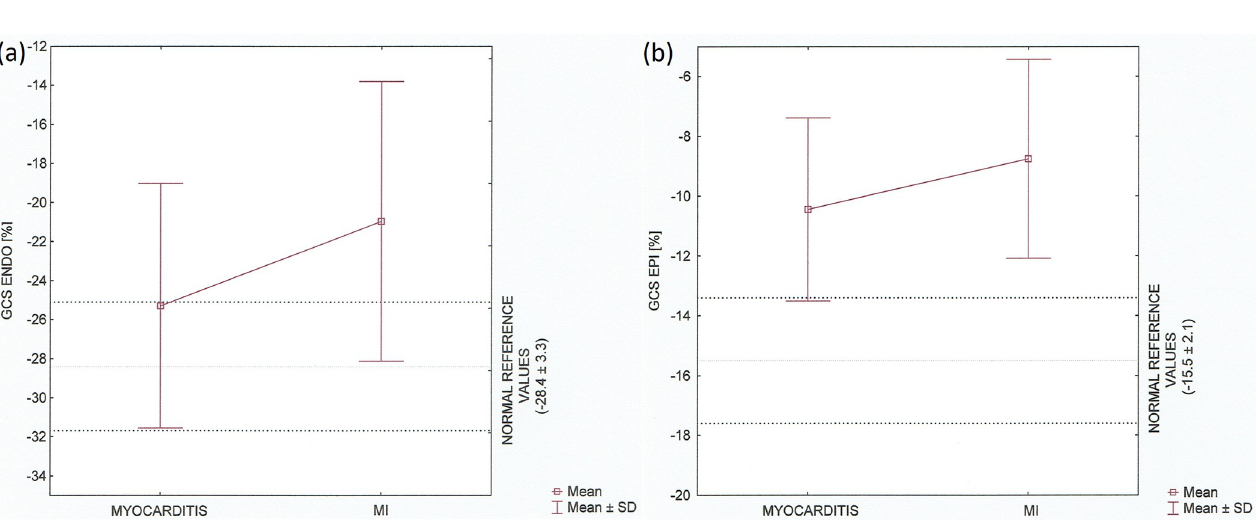
Fig 6. Global circumferential endocardial and epicardial strain in the myocarditis and MI groups. Data are shown as Tukey boxplots, taking into account normal reference values for age, p < 0.05 (a) Endocardial GCS [%]. (b) Epicardial GCS [%].